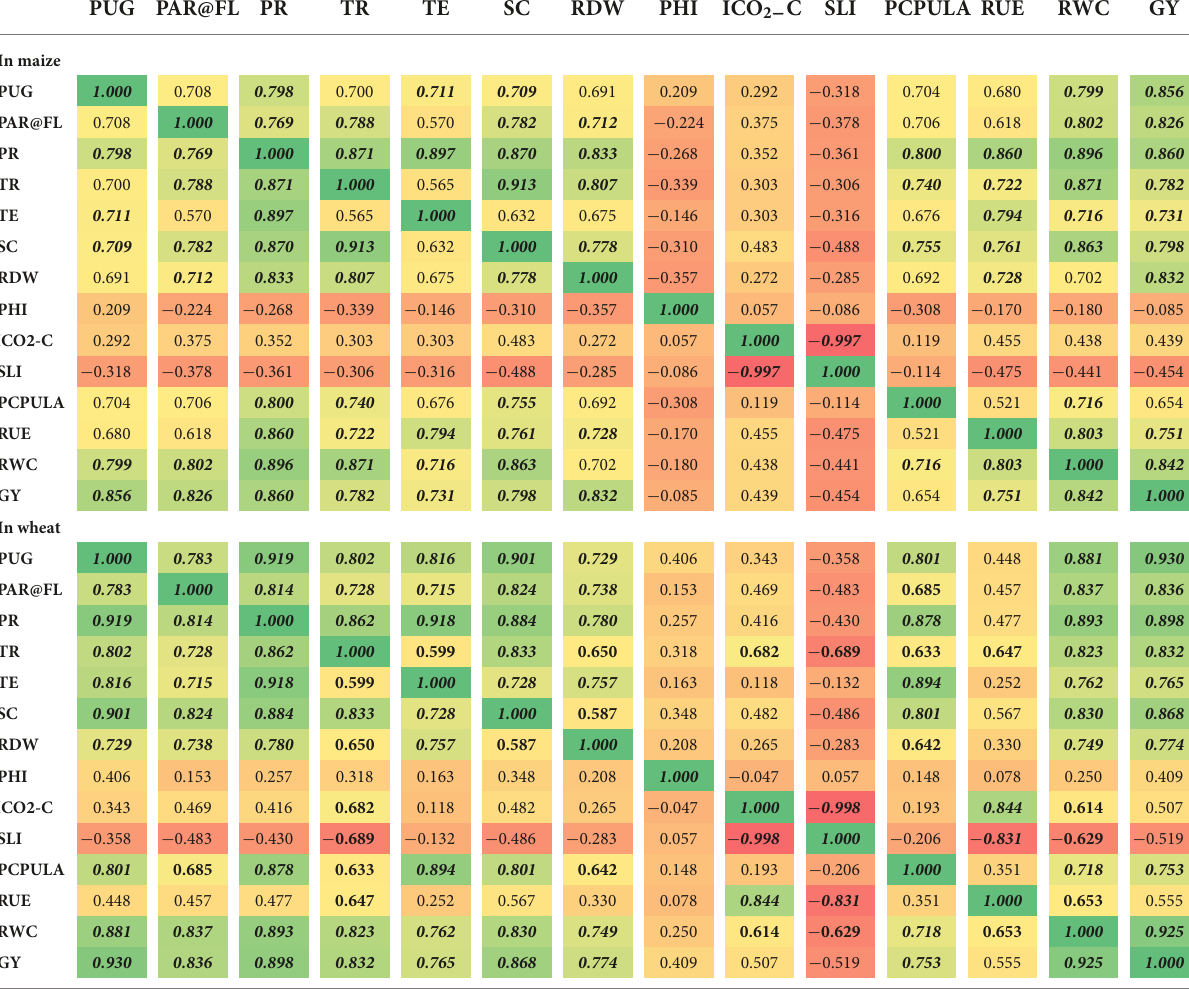
TABLE 5 Pearson’s correlation coefficients matrix (r) between photosynthetic indices, RUE, RWC, RDW, and P-uptake in grains (PUG) of maize and